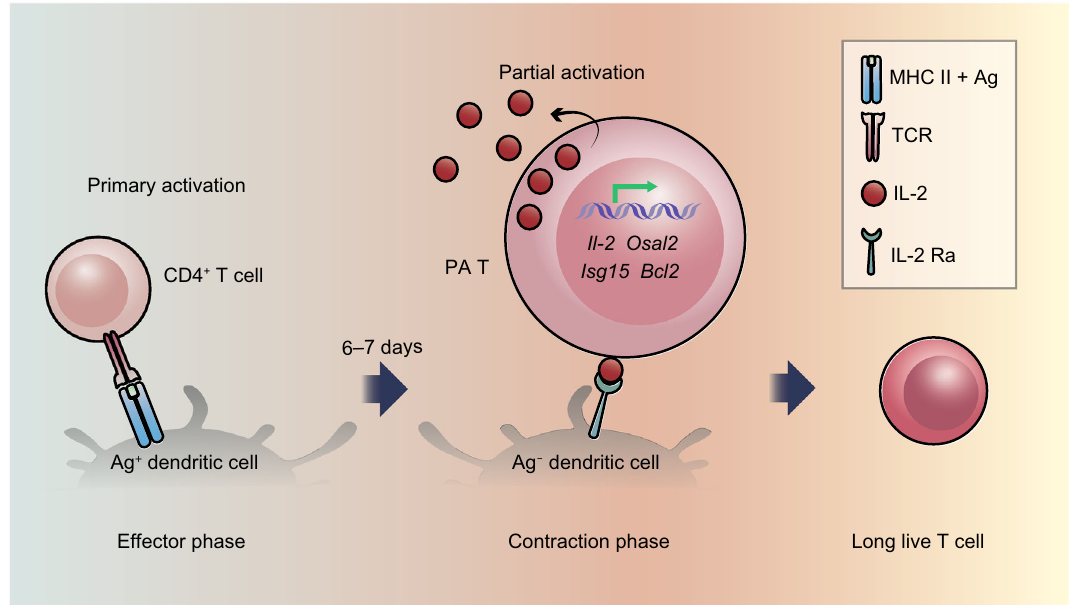
Figure 7. The proposed programing in PA T after DC contact. Schematic overview of the interplay between IL-2, DCs,